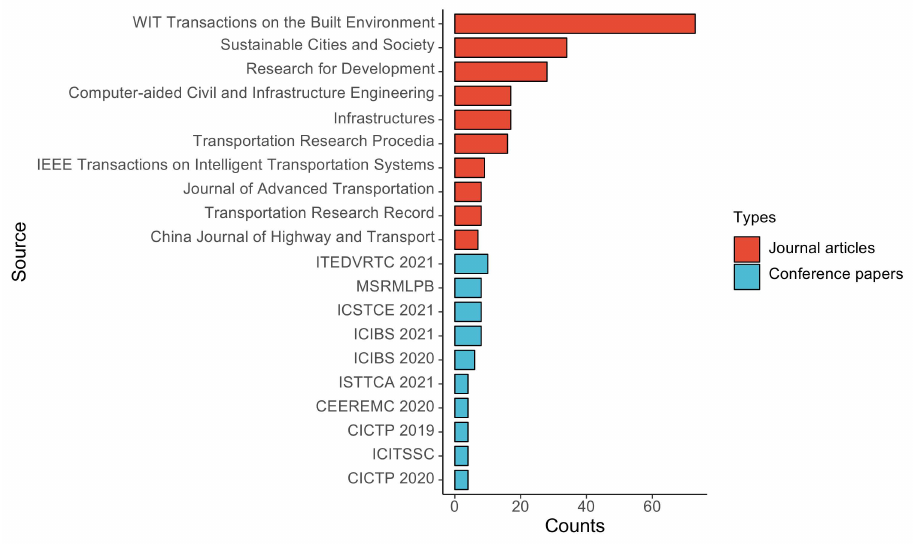
Figure 4. Most Relevant Journals and Conference Sources.